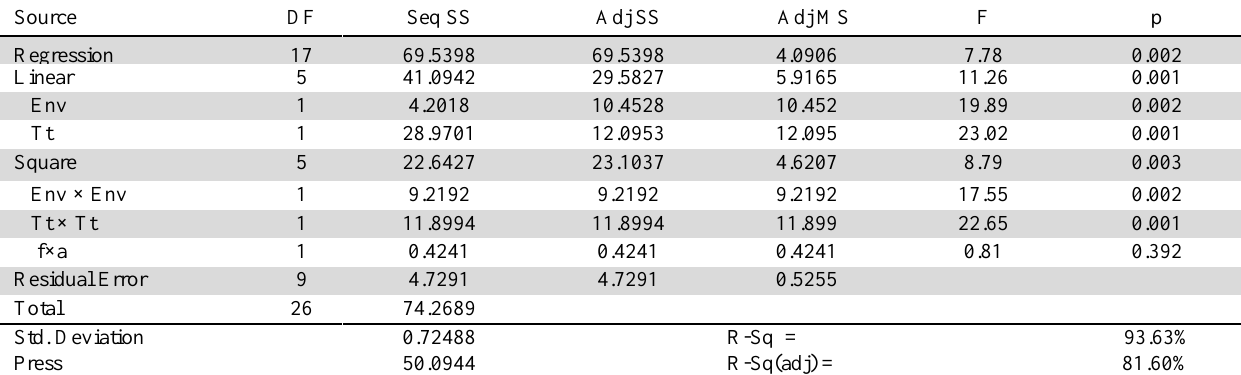
Analysis of Variance results for Surface Roughness Ra (Significant terms Only)